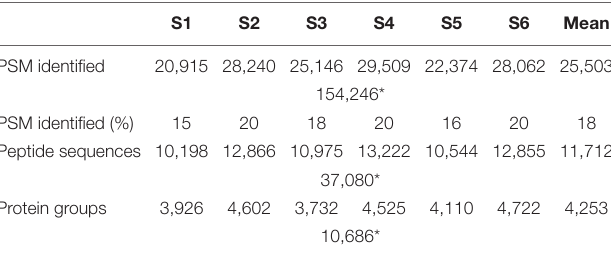
TABLE 2 | Metrics of metaproteome analysis of healthy adult stool samples